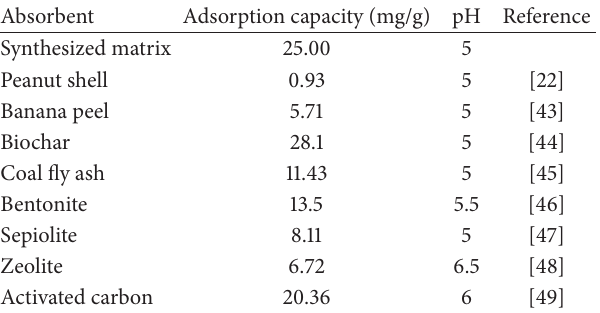
Figure 2: Effect of pH on the adsorption of Cd 2+ on biomass ash and modified biomass ash (initial concentrations of Cd 2+ , 50 mg/L; biomass ash concentration, 4g/L; T = 30 ∘ C). Table 3: Comparison of Cd 2+ adsorption capacities of different absorbents.